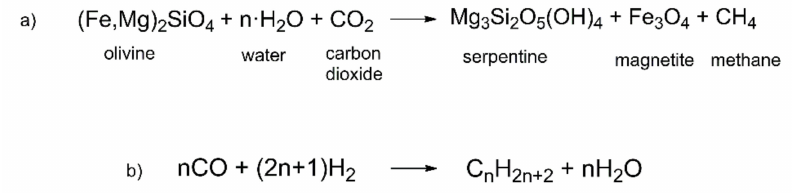
Scheme 1. Principal reactions occurring in the Hadean time. Panel A: serpentinization